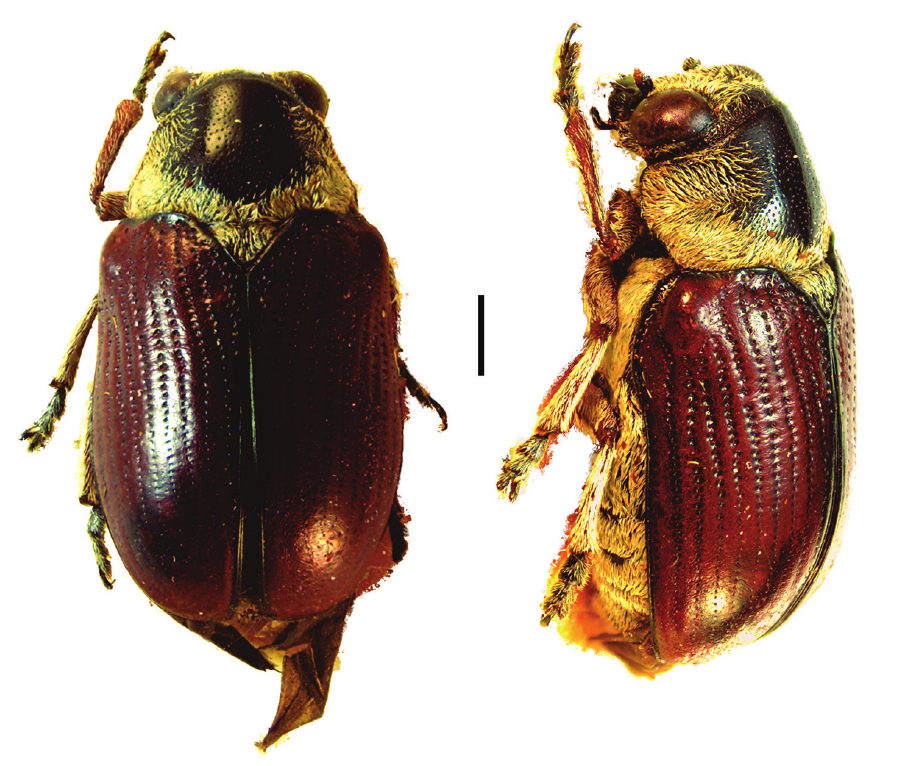
Figure 18. Euryscopa ( Coleomonrosa ) haematoptera Lacordaire (1) , left: habitus (dorsal view), right: habitus (lateral